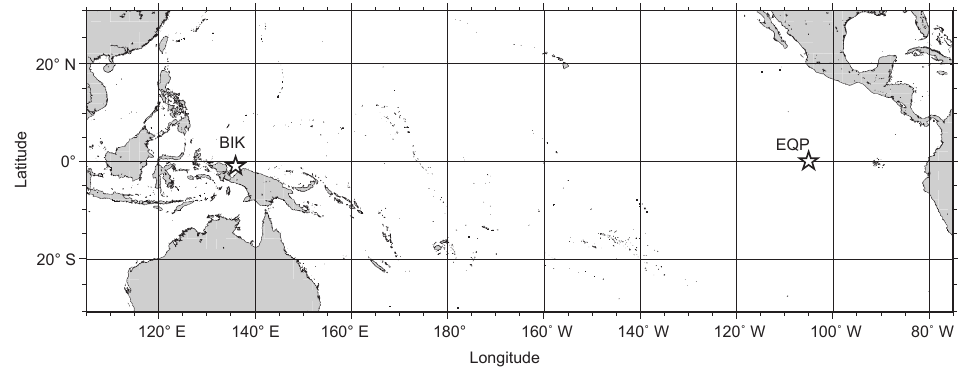
Figure 1. Map showing balloon launching sites. EQP, eastern equatorial Pacific; BIK, Biak Island,